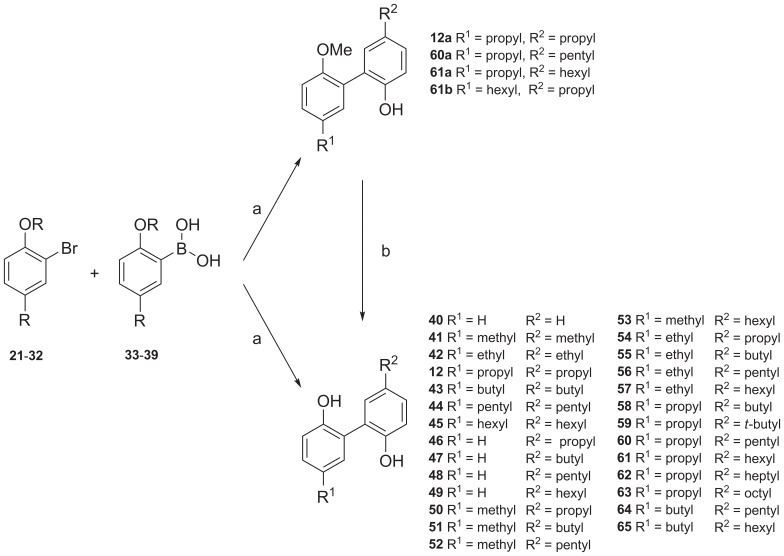
Synthesis of magnolol derivatives and analogs.(a) Pd(PPh3)4, Na2CO3, toluene, EtOH, H2O, 100°C, 18h; (b) CH2Cl2, BBr3, −78°C to rt.